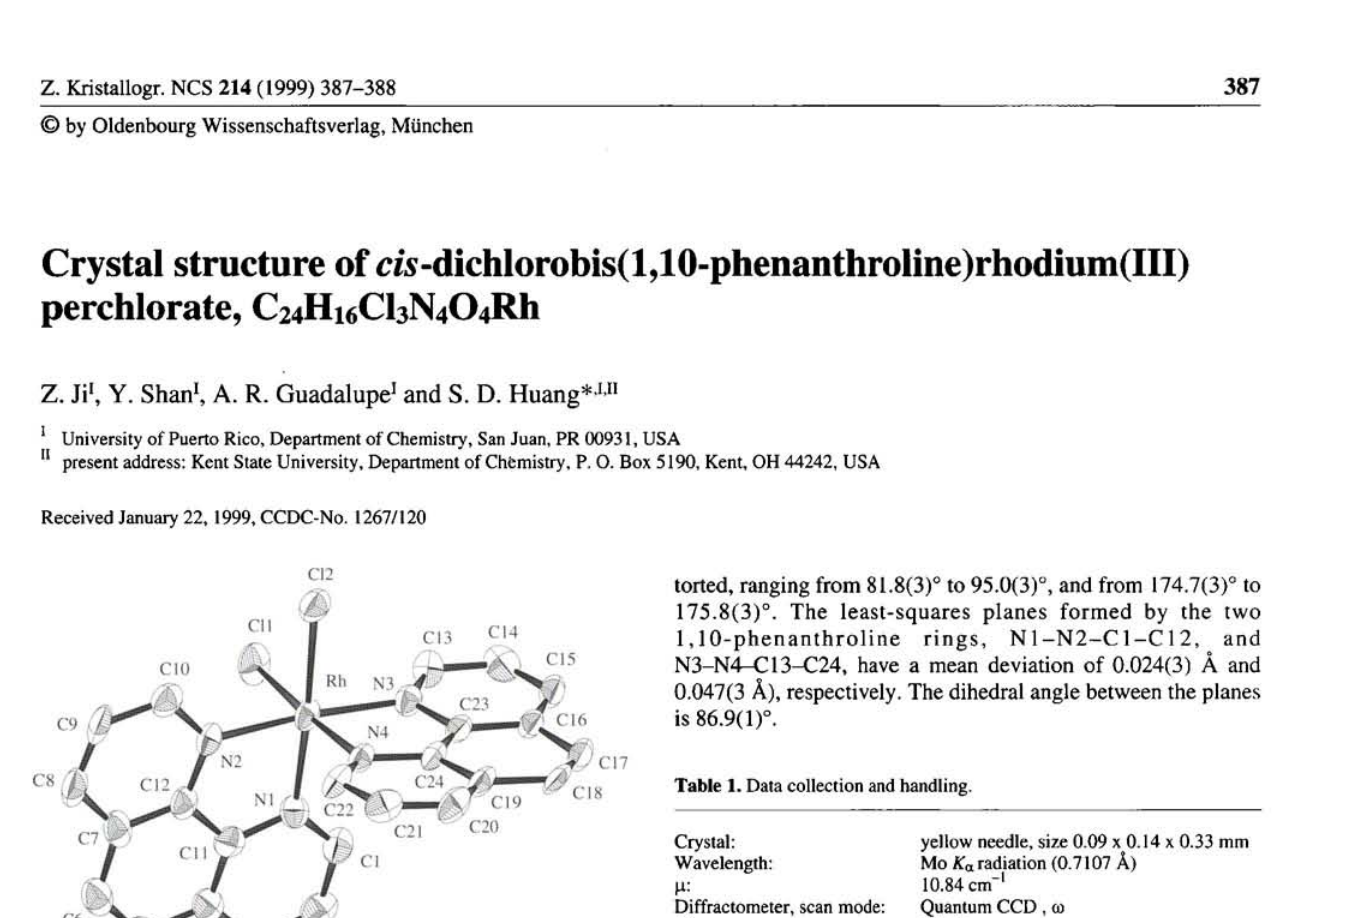
Table 2. Atomic coordinates and displacement parameters (in À